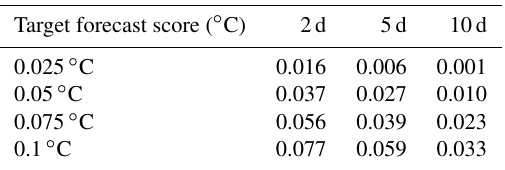
Table 3. Initial SST accuracy required (CRPS score, in ◦ C) to ob- tain the target final accuracy (CRPS score, left column) with a 95% confidence for different forecast time lags: 2, 5 and